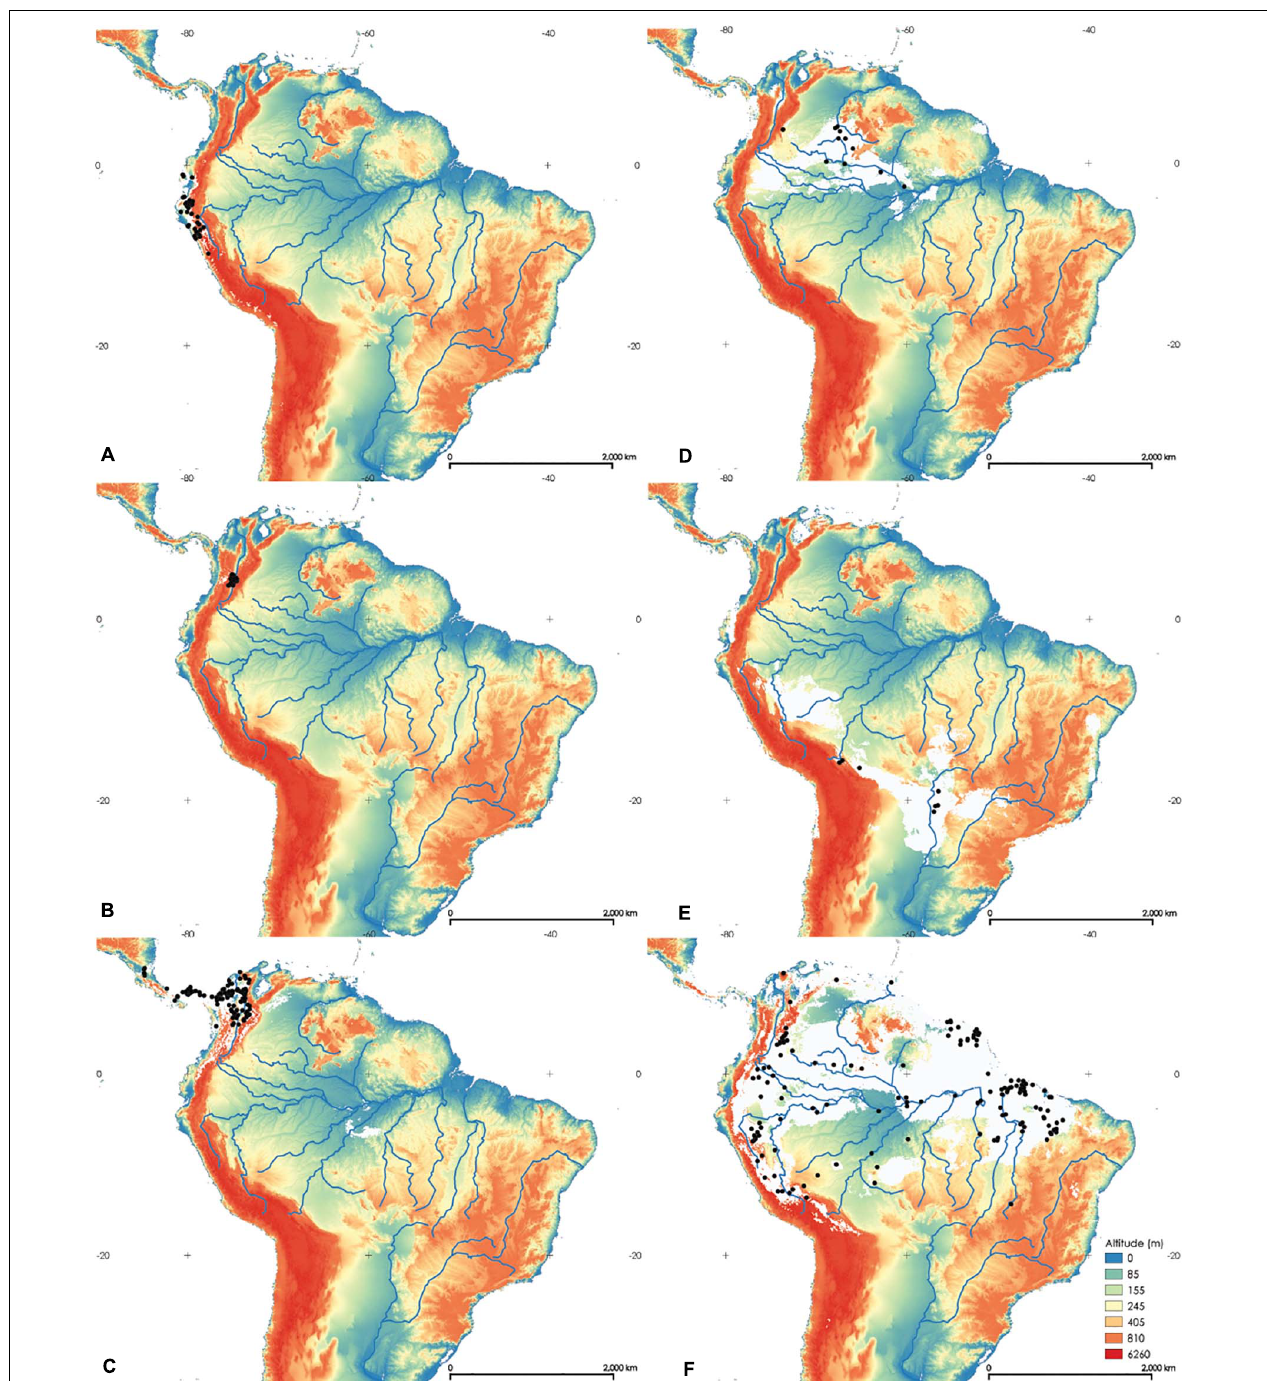
FIGURE 4 | Maps of the potential distribution of Rhodniini based on 19 bioclimatic variables in the study area. pallescens group— (A) Rhodnius ecuadoriensis , (B) R. colombiensis , (C) R. pallescens ; pictipes group— (D) R. brethesi , (E) R. stali , (F) R. pictipes . The white areas comprise the probability value at which 90% of the presence points fall within the potential area. The black dots indicate records of each